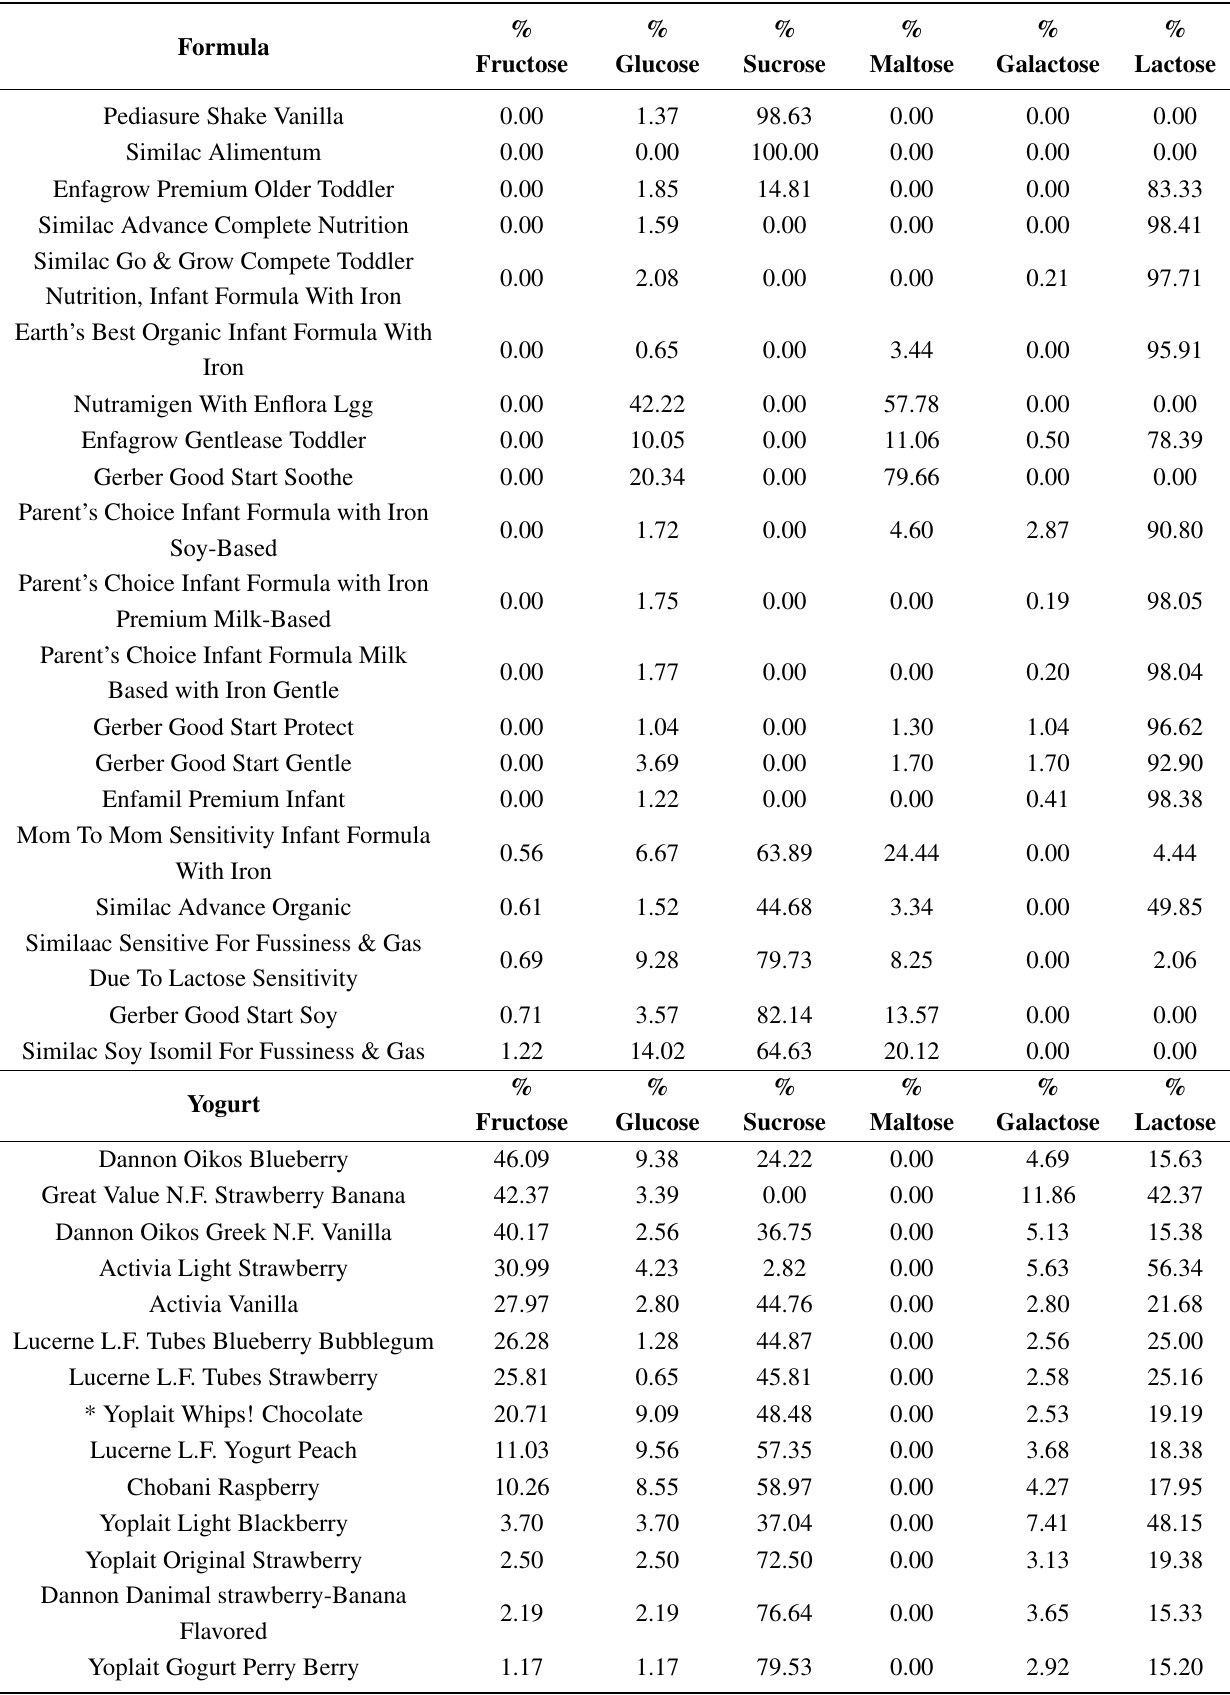
Table 1. Percentage of Total